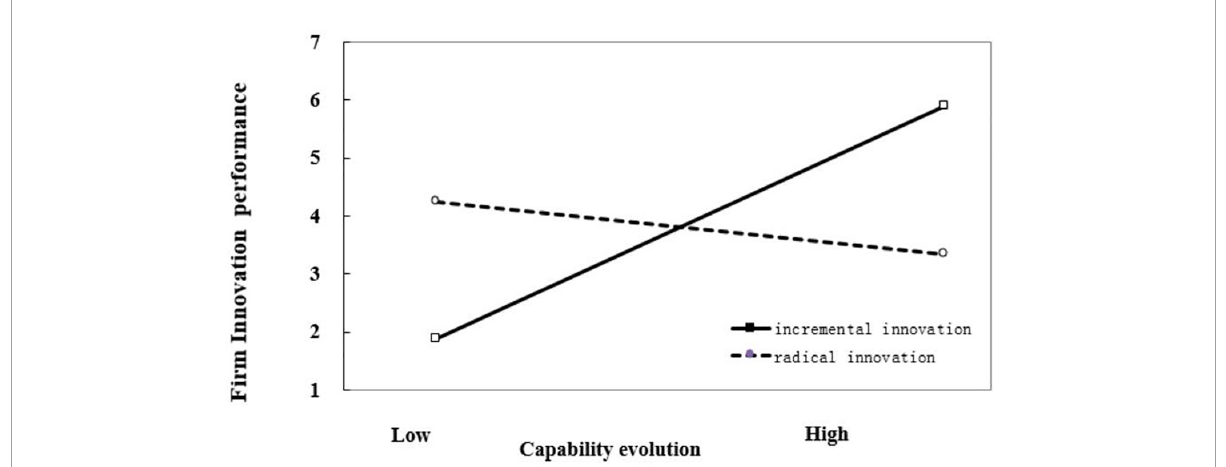
FIGURE2 Moderating effect of innovation magnitude on the relationship between capability evolution and firm innovation performance in the late stage of catch-up.